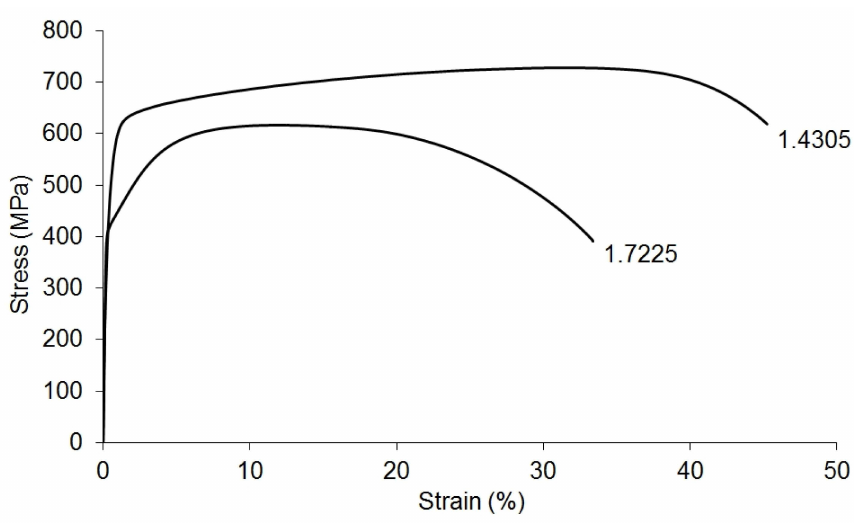
Figure 2. Uniaxial engineering stress-strain ( σ - ε ) diagrams for the considered materials